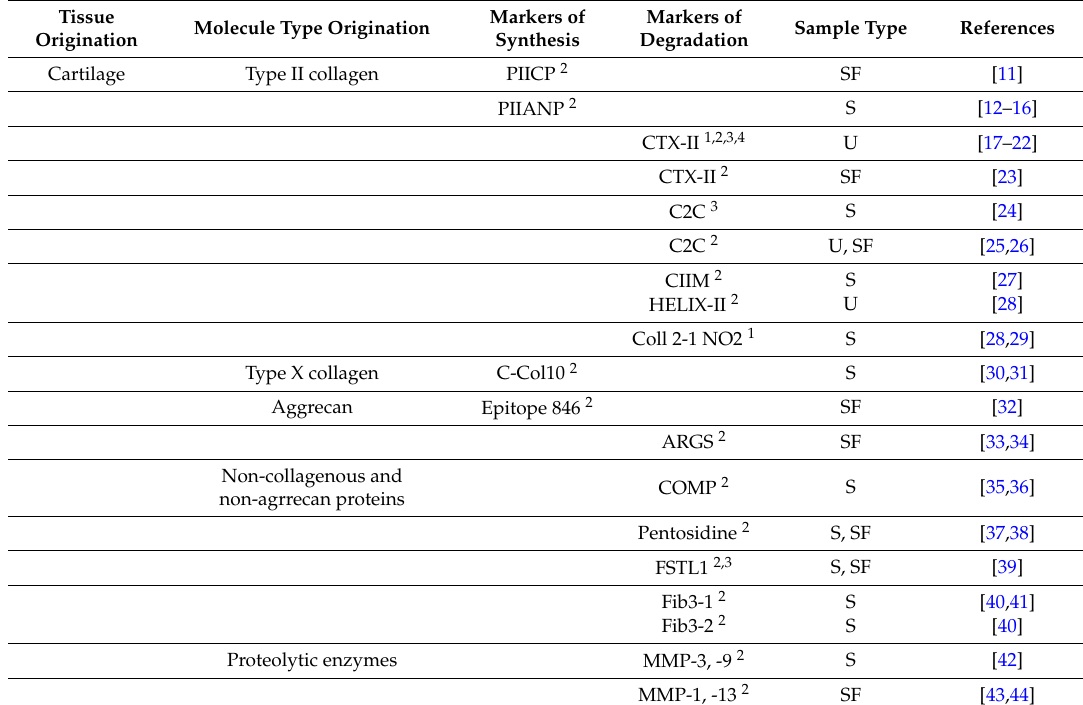
Table 1. Selected OA biomarkers of bone, cartilage and synovium metabolism and studies of these markers in